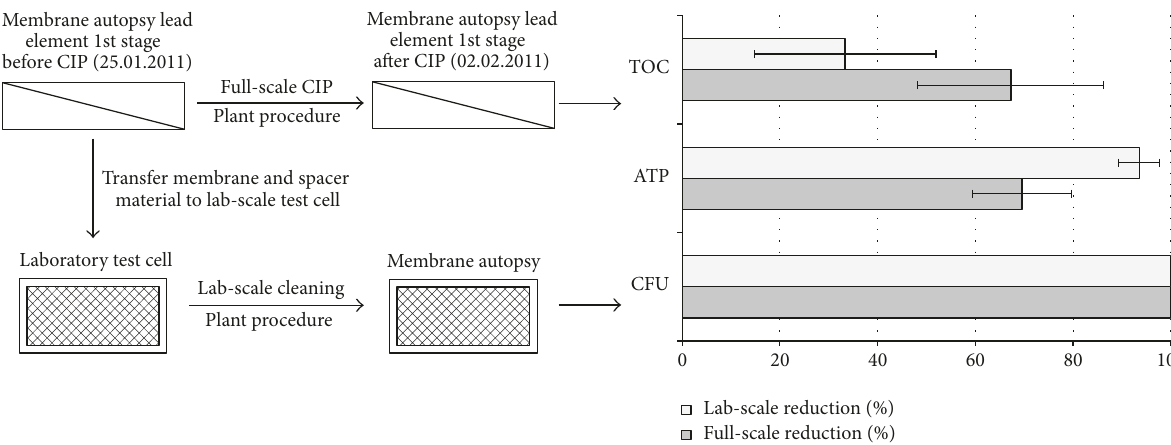
Figure 6: Laboratory cleaning setup and TOC, ATP, and CFU reduction after standard plant cleaning procedure in full-scale and laboratory- scale test cell at location I.